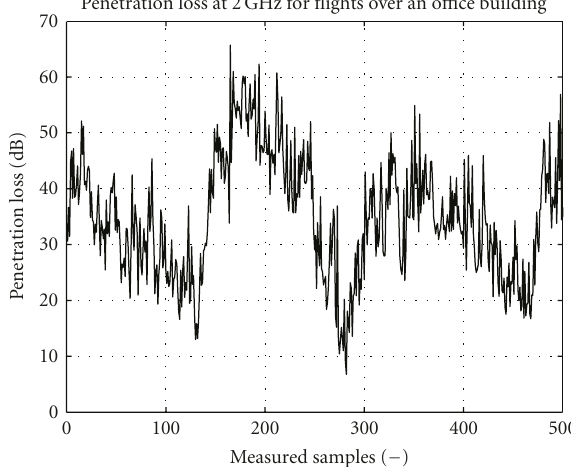
Figure 2: An example of measured received signal level at 2.0 GHz. Figure 3: An example of extracted penetration loss into the ground floor of an o ffi ce building.